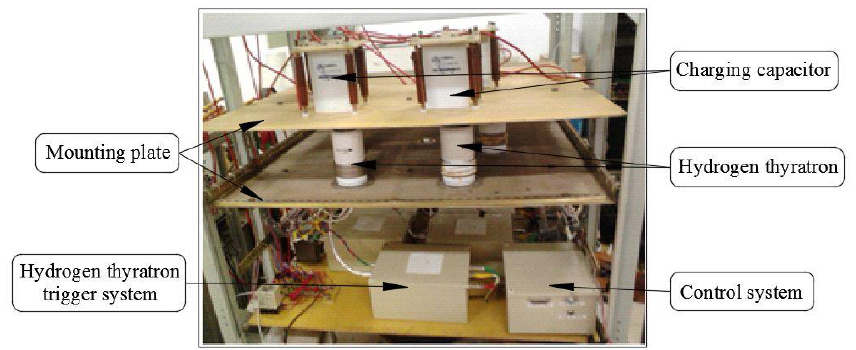
Figure 12. Experimental test bench.